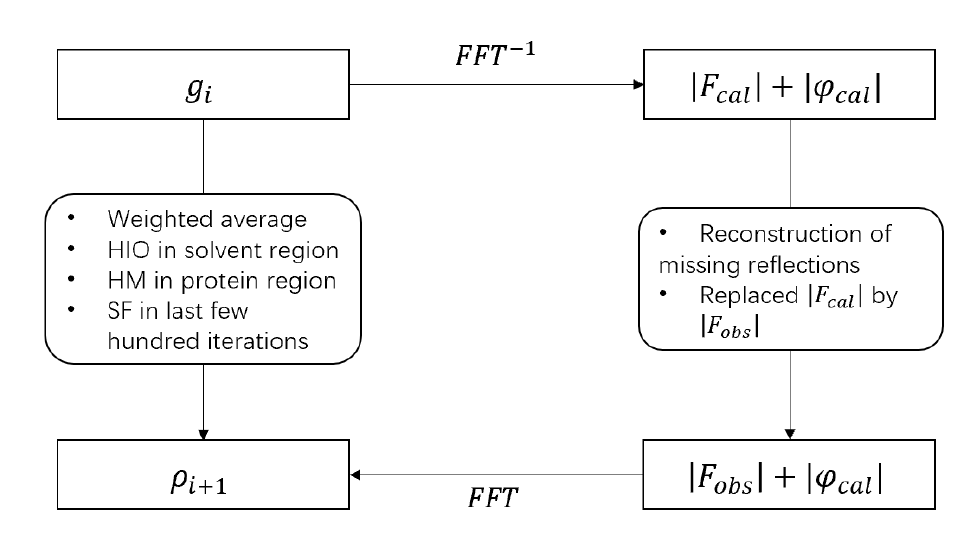
Figure 1. The flowchart for an iteration cycle of direct phasing with hybrid-input-output (HIO). The initial density is random. g i is the input density of the i th iteration. ρ i + 1 is the output density before density modification of the i th iteration. | F obs | is the diffraction data downloaded from the protein data bank